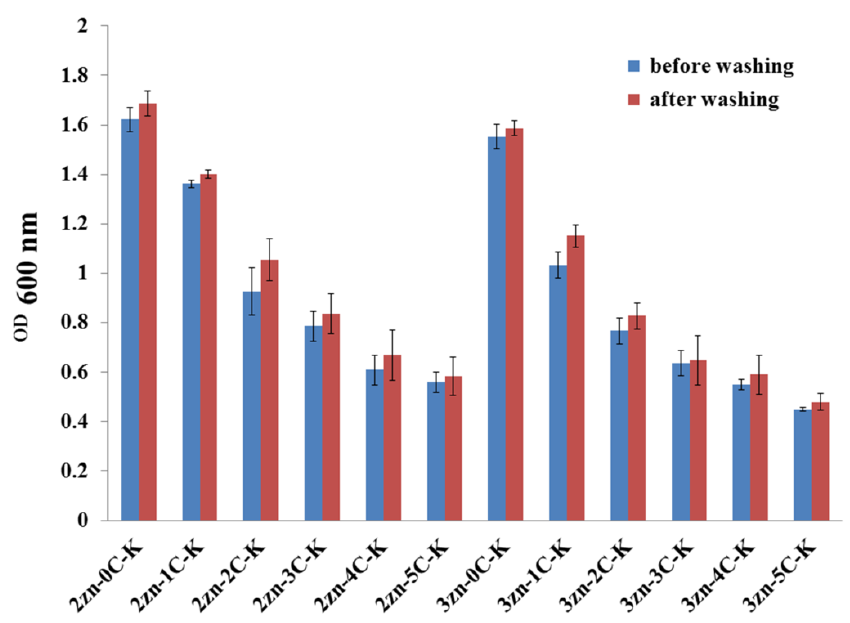
Figure 6. Antimicrobial efficacy of functional knitted fabrics before and after washing as related to the twist